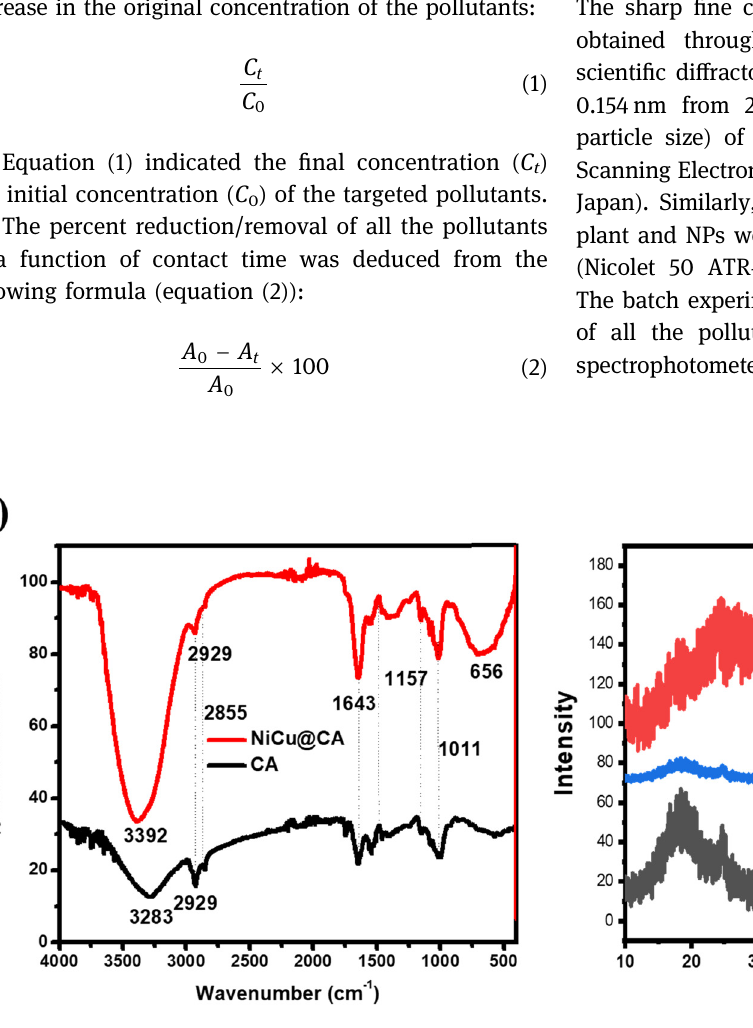
Figure 1: FTIR ( a ) and XRD ( b ) spectrum of CP and CuNi@CP NPs. In the XRD spectrum, CuNi@CA - 1 and CuNi@CA - 2 indicated the XRD spectrum before and after the reactions,